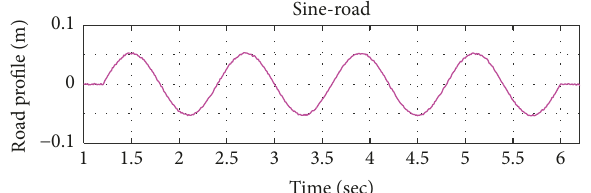
Figure 11: The sine-typed track profile is used to estimate the AT2FC.